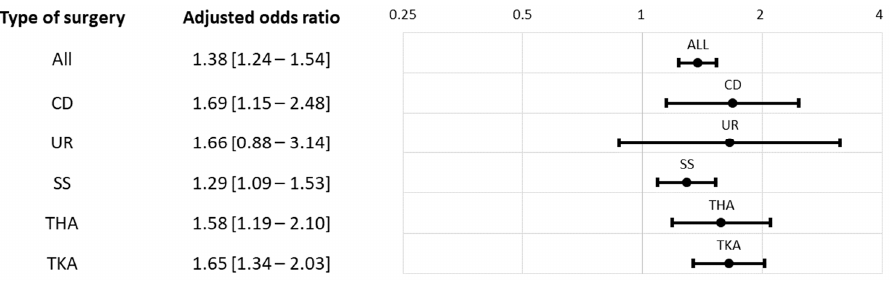
Figure 1. Adjusted odds ratio of post-30-day opioid Rx for index high MME vs. low MME. Abbre- viations: CD, cesarean delivery; THA, total hip arthroplasty; TKA, total knee arthroplasty; SS, spine surgery; UR, hysterectomy (uterus removal).